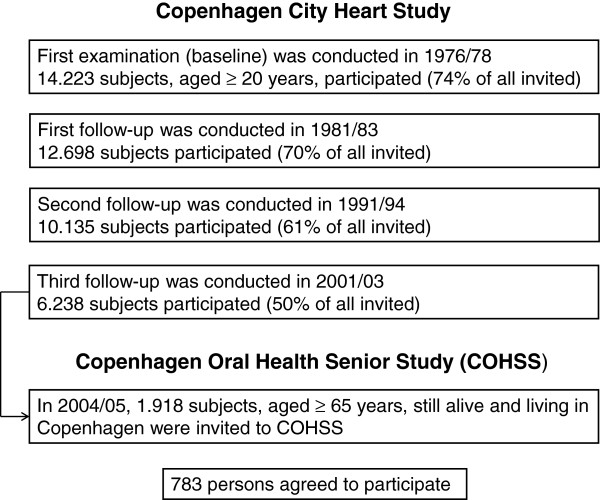
Flow chart for participants in the Copenhagen Oral Health Senior Study.